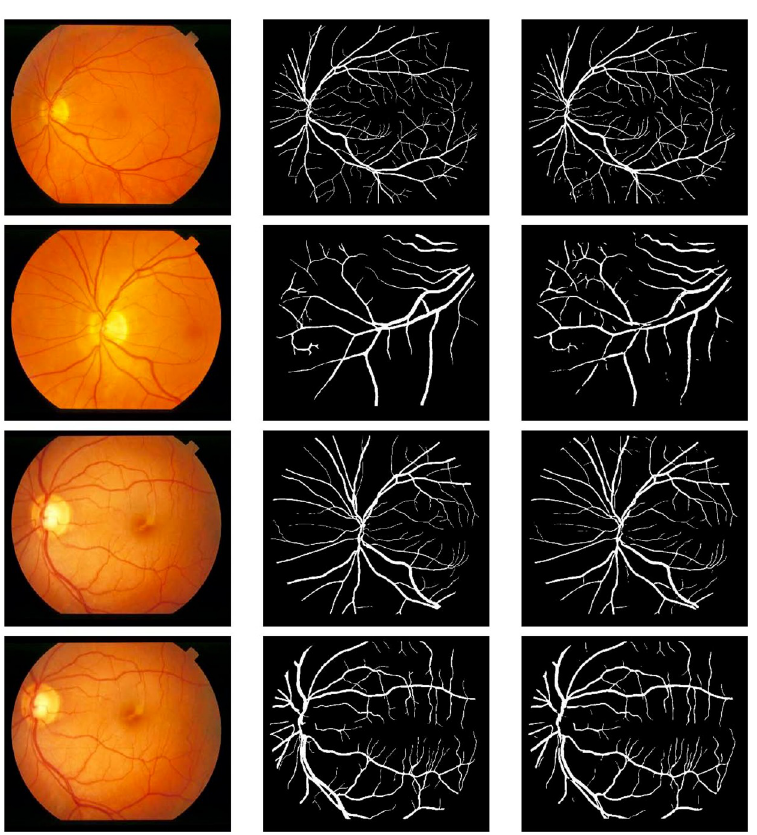
Fig 6. Visual results on the STARE dataset. From left-to-right: input images, ground truth, result obtained by our proposed method.